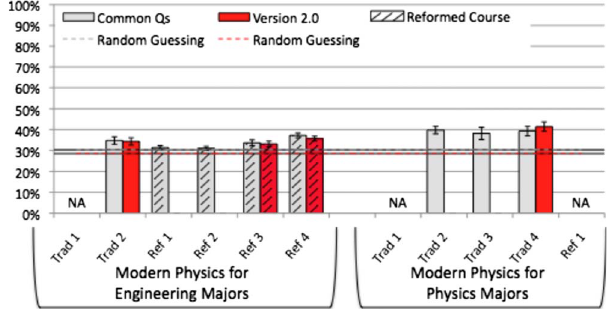
FIG. 1. (cid:1) Color (cid:2) Average pretest scores in different modern phys- ics courses for common questions (cid:1) gray/light (cid:2) and Version 2.0 ques- tions (cid:1) red/dark (cid:2) . Solid colored bars indicate courses taught with traditional instruction and cross-hatched bars indicate reformed courses. Error bars show standard error on the mean. The two dashed horizontal lines show the average score that would be ex- pected if students answered using random guessing for the common questions (cid:1) gray/light (cid:2) and Version 2.0 (cid:1) red/dark (cid:2) . The chart includes some courses in which no pretest was given in order to compare more easily to Fig. 2.